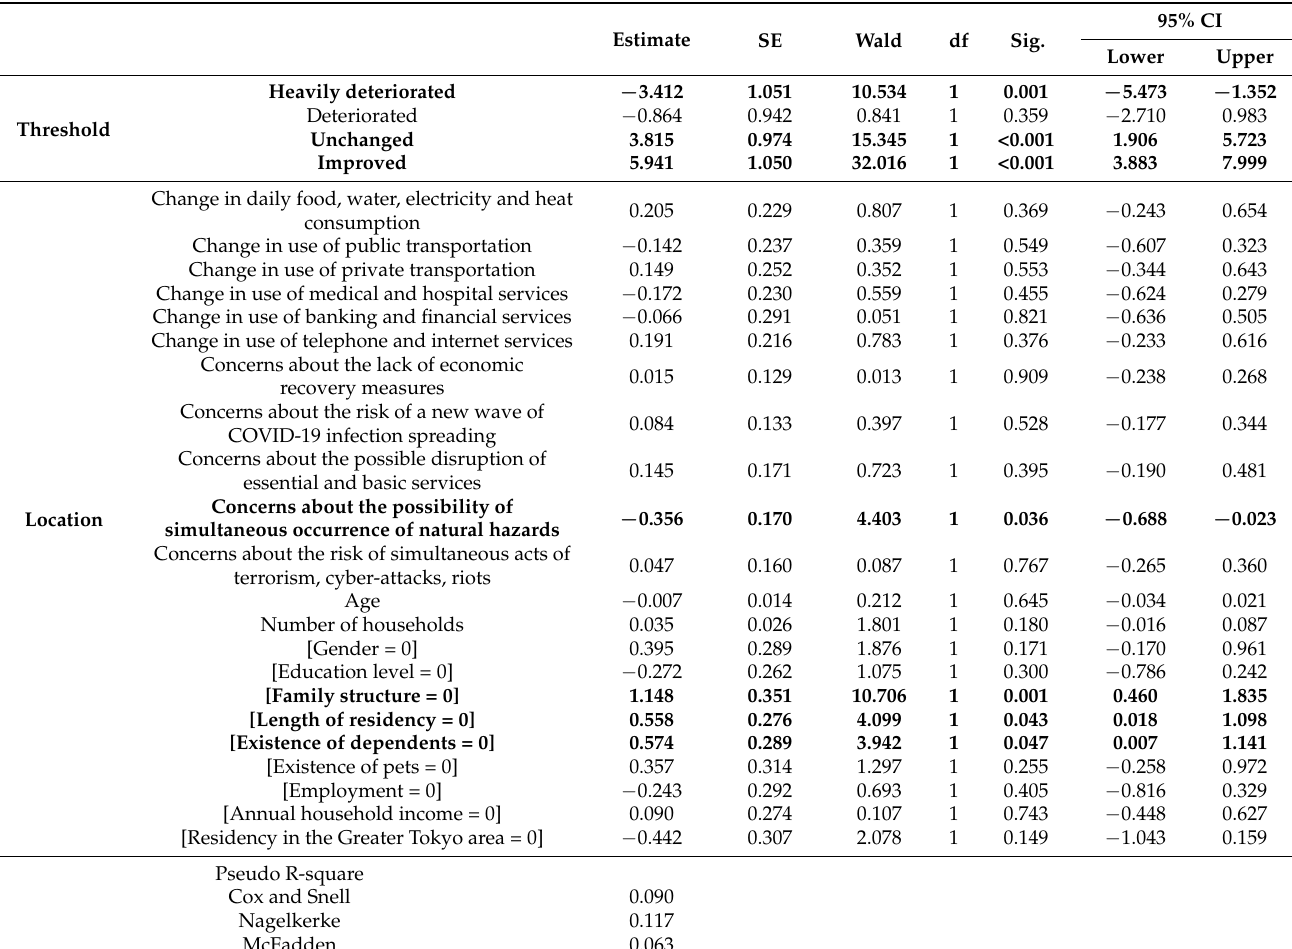
Table 3. Parameter estimates for change in satisfaction with